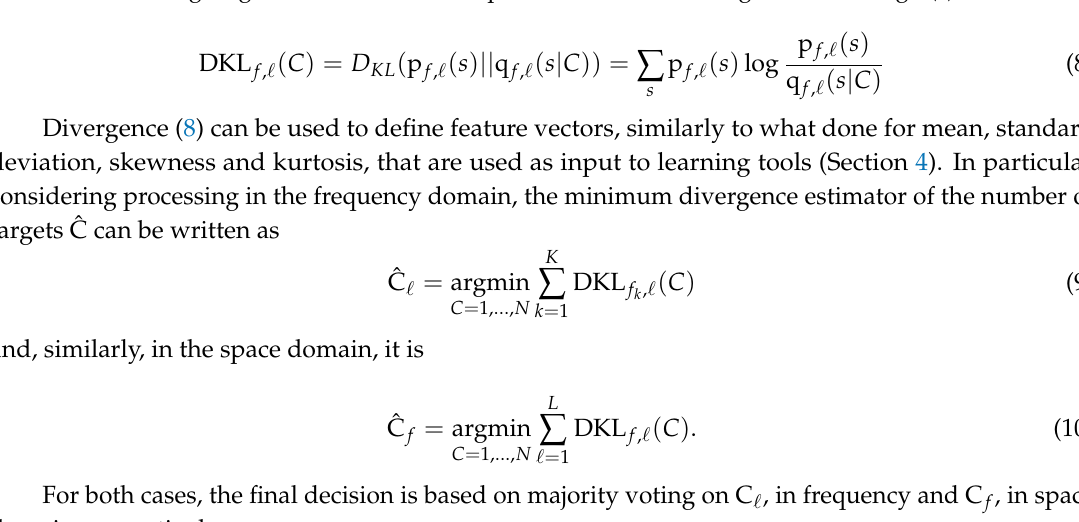
, σ f , ζ f , κ f } (7) domains. f